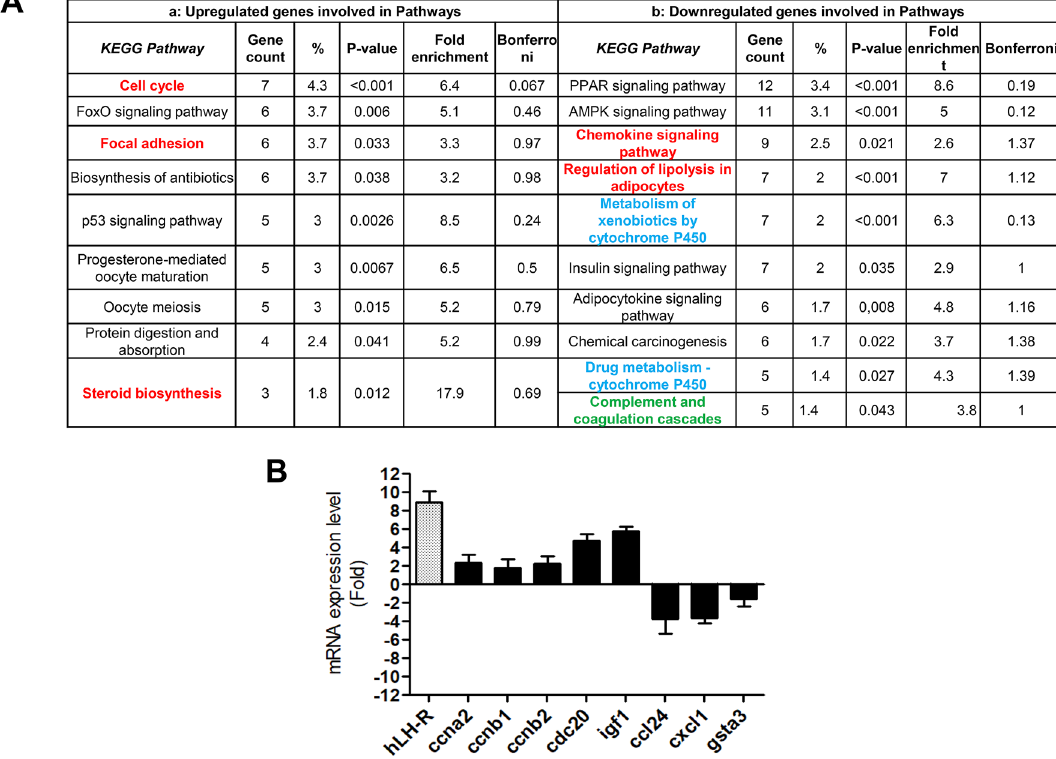
Figure 4. A: Pathways enrichment analysis of upregulated ( a ) and downregulated ( b ) genes, using p -values < 0.05 as threshold. The transcriptomic analysis was performed on uteri of two 6-months old TG mice (belonging to the TG-hLH-R-frt-200 mouse line) and WT mice. Table shows the number and the percentage of genes involved in each pathway, with the relative fold enrichment. For this analysis the Bonferroni correction was applied. ( B ): Bar-graph of the mRNA fold increase of 8 genes (excluding hLH-R) showing alterations between TG and WT mice in the microarray data. Data are reported as log2 of 2 -DDCt . The Log2 fold change values from microarray data and Log2 fold change values from RQ-PCR data are used to perform Pearson Correlation Test. p = 0.0032 (two-tailed t -test; n = 4, 2 WT vs 2 TG). R square = 0.85 (Pearson correlation